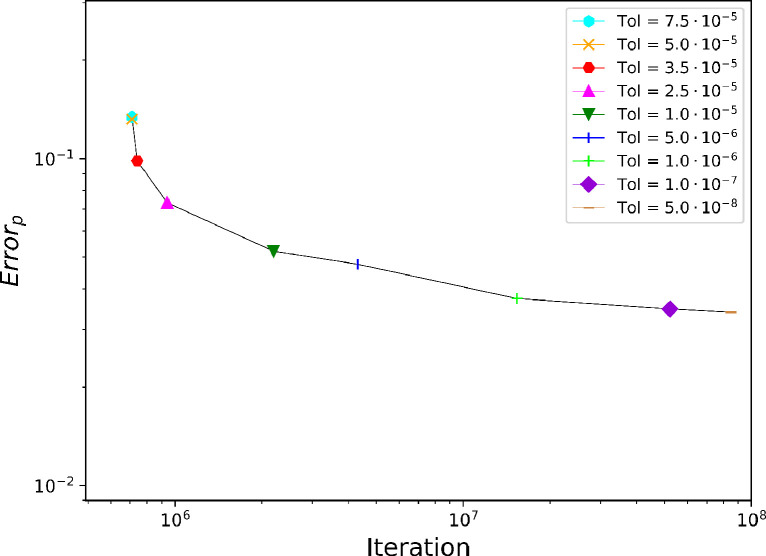
Entry capillary pressure predicted by LBM and total number of time iterations for different values of the tolerance. The error starts to increase significantly from Tol=10−5%